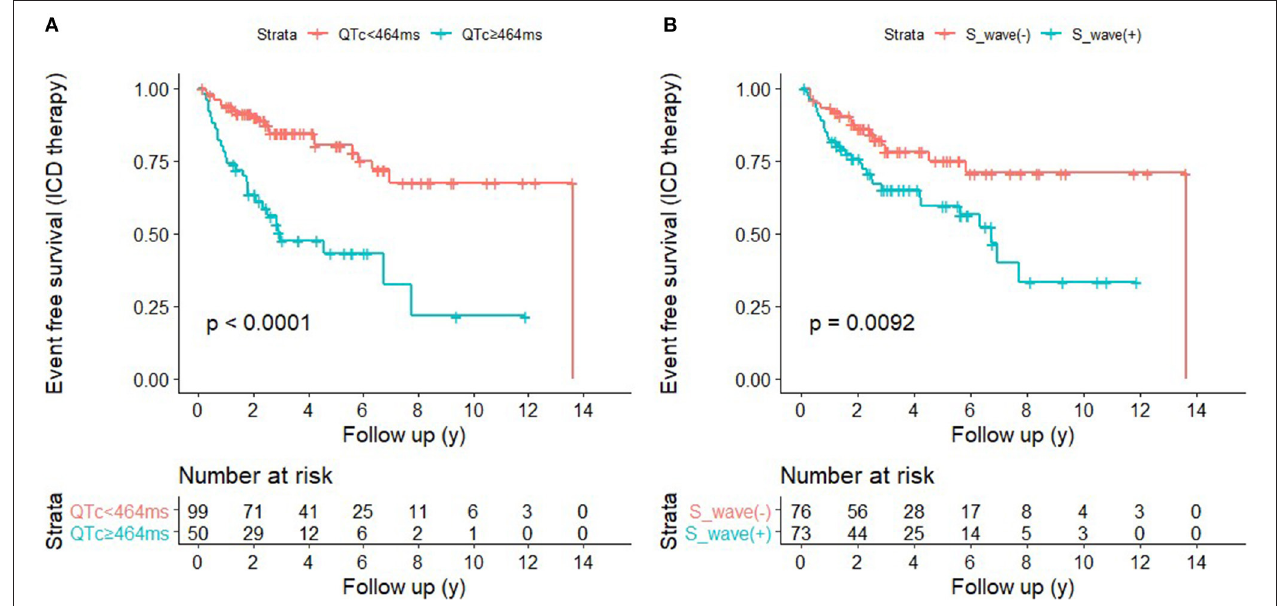
FIGURE 3 | Kaplan-Meier survival analysis based on QTc interval (A) and wide or deep V4- S wave (B)